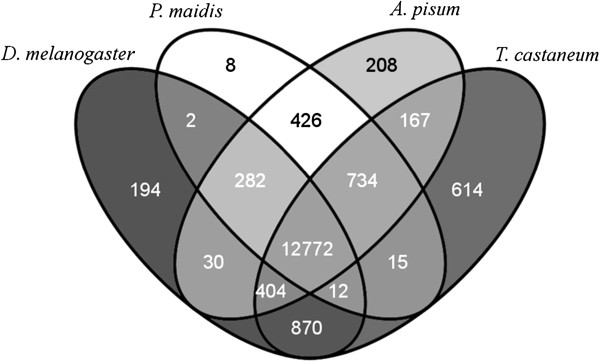
Venn diagram showing tBLASTx (
E
-value <10
-10
) pair-wise ortholog matches of
Graminella nigrifrons
to three invertebrate species with characterized transcriptomes (
D. melanogaster
: 19,233 transcripts;
A. pisum
: 37,994 transcripts;
T. castaneum
: 14,366 transcripts) and one species with a dbEST database (
P. maidis
: 10,636 ESTs).